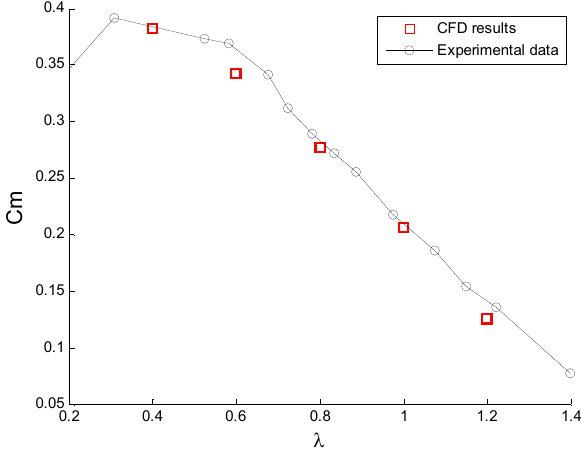
Figure 6. Results for numerical method